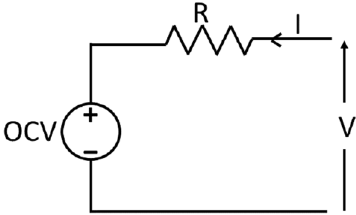
Figure 1. Electrical equivalent circuit of battery.